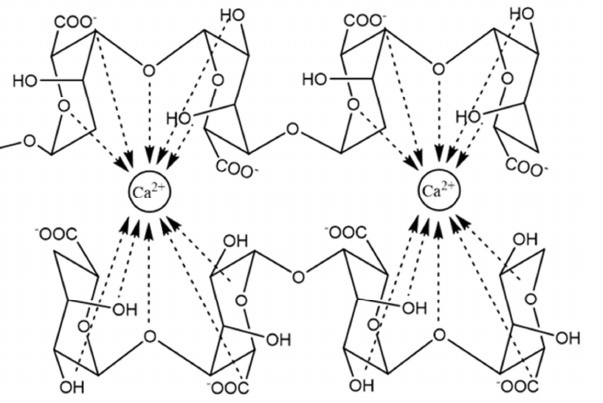
Figure 3. The junction zone in the egg ‐ box model of calcium alginate gel. Reproduced from [88].